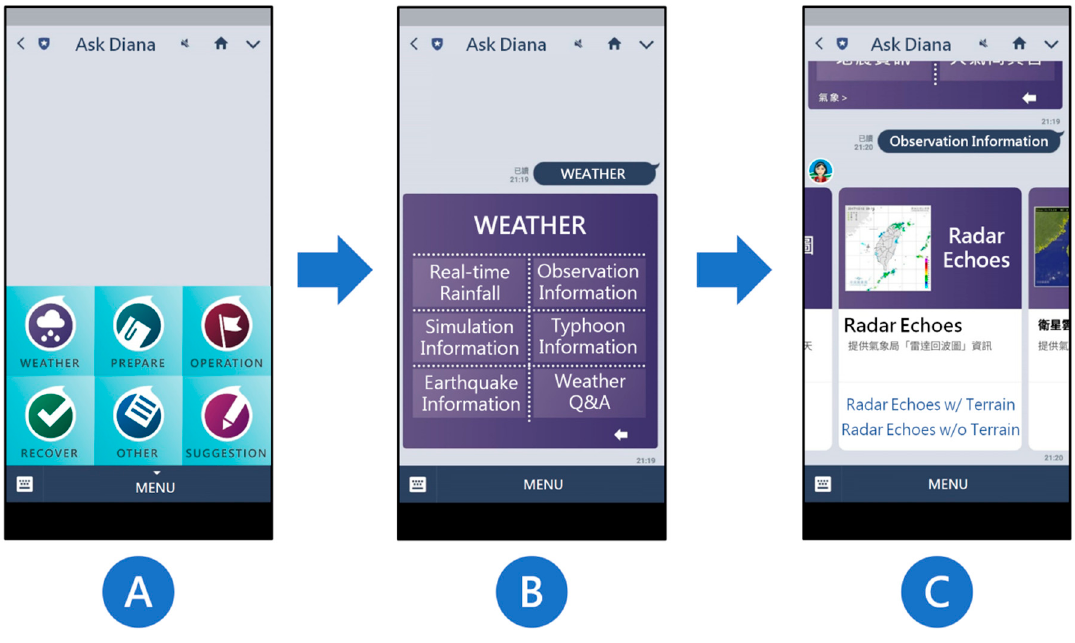
Figure 6. Three kinds of menus of Ask Diana: ( A ) Main menu; ( B ) image map menu; ( C ) carousel menu.